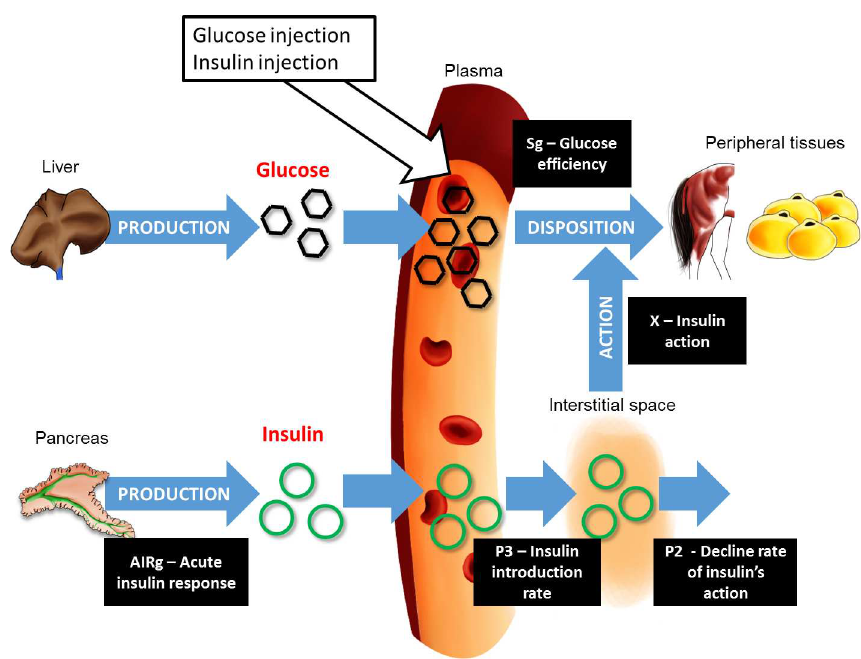
Fig 2. Schematic representation of the Bergman’s minimal model (adapted from [34–36,38]). Glucose is produced and releasedby the liver in a basal state. After a meal, or a glucose intra-venous injection, the levels of plasma glucoseincrease.From the blood, the glucose will be disposedin the peripheral tissues by two ways: • By itself. The glucoseefficiency ( Sg ) is the capacity of the glucoseto mediateits own disposal. • Mediatedby insulin. The elevated concentration of blood glucose inducesthe production of insulinby the pancreas. The acute insulinresponse( AIRg ) representsthe productionof insulinby the pancreas during the first 10 minutes after glucoseinjection. Insulinis transferred into the interstitial space ( P3—insulin introduction rate ) from the bloodstreamand reaches the peripheraltissues to mediate glucosedisposal ( X -insulin action ). With time, insulinaction declinesat a rate calculatedby the P2 proxy. Insulin sensitivity ( IS ) is calculatedas P2/P3. Finally, the dispositionindex ( DI ) (multiplicationof IS and AIRg) is used to describe β -cells